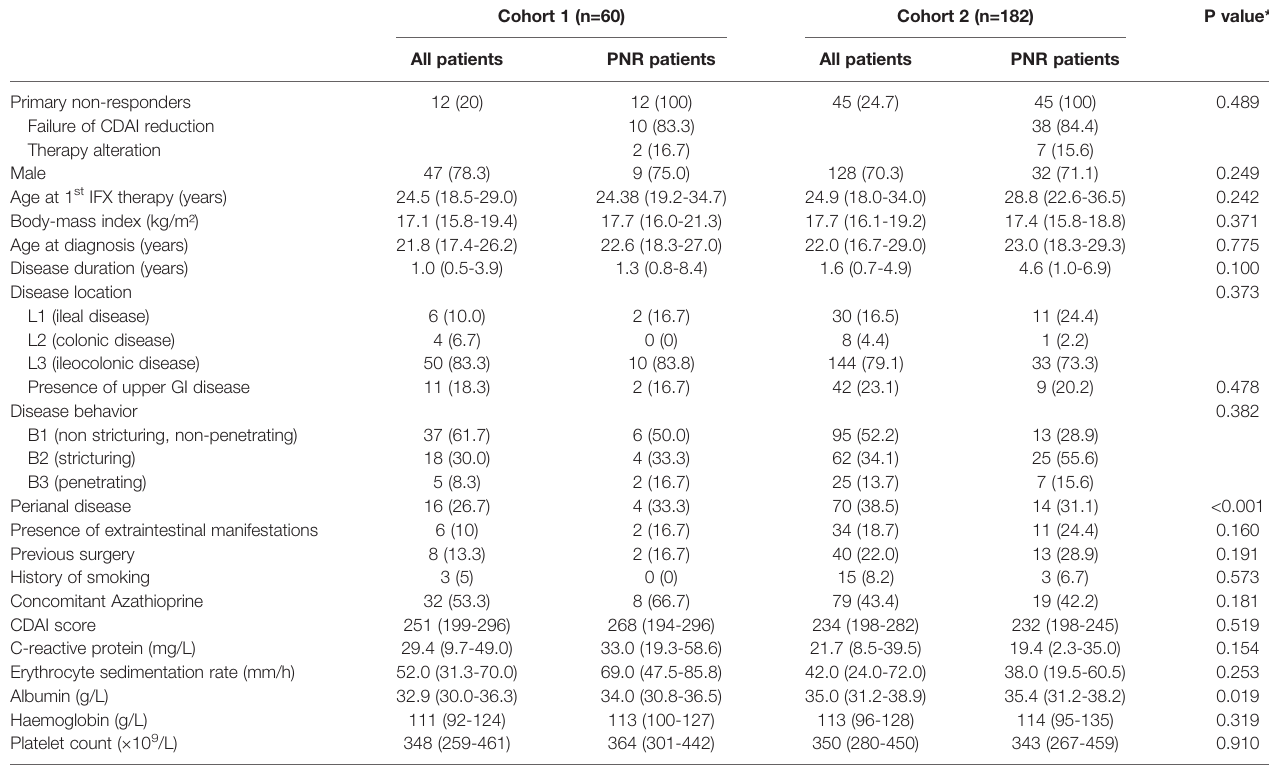
TABLE 1 | Baseline characteristics of Cohort 1 and